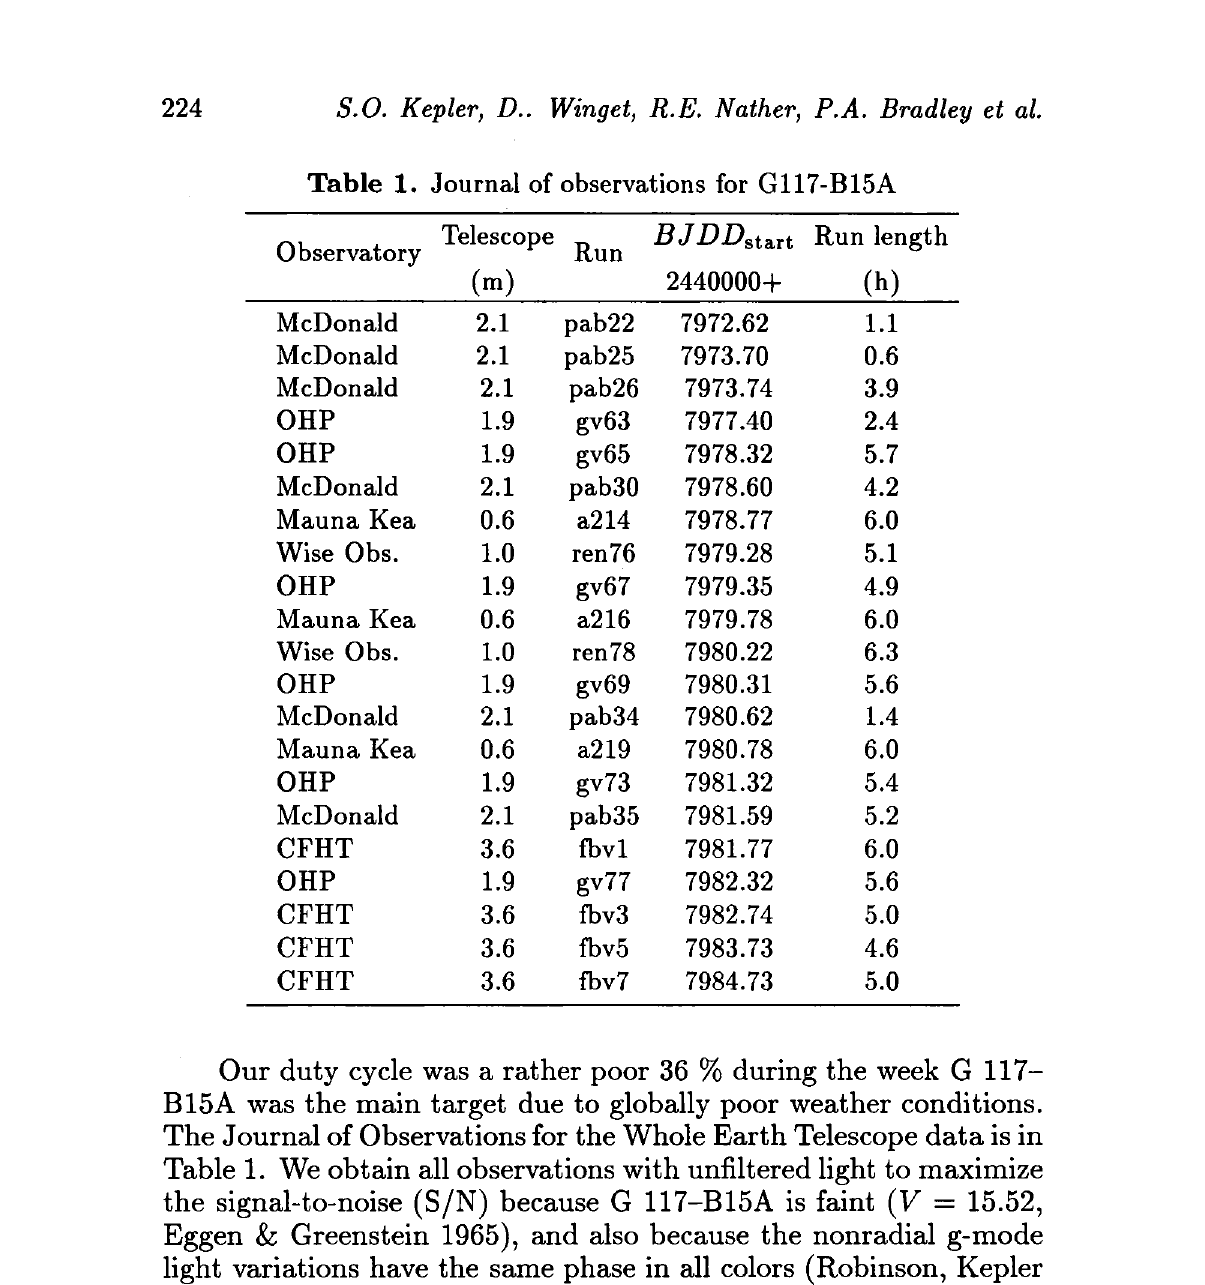
Table 1. Journal of observations for